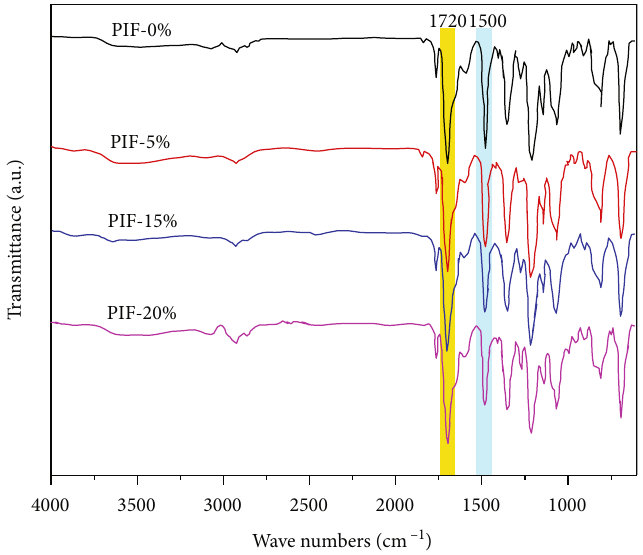
Figure 6: FTIR spectrum of PIFs with di ff erent HMDA contents.